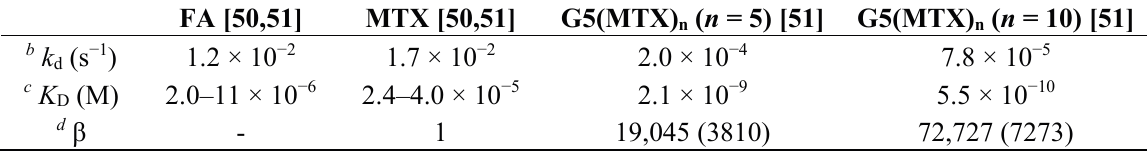
Table 2. Kinetic and equilibrium dissociation constants of FA, MTX and